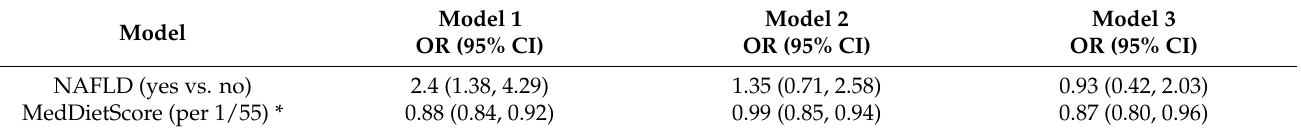
Table 3. Logistic regression models predicting 10-year CVD risk and the role of NAFLD and Med- DietScore ( n = 477) 1 .